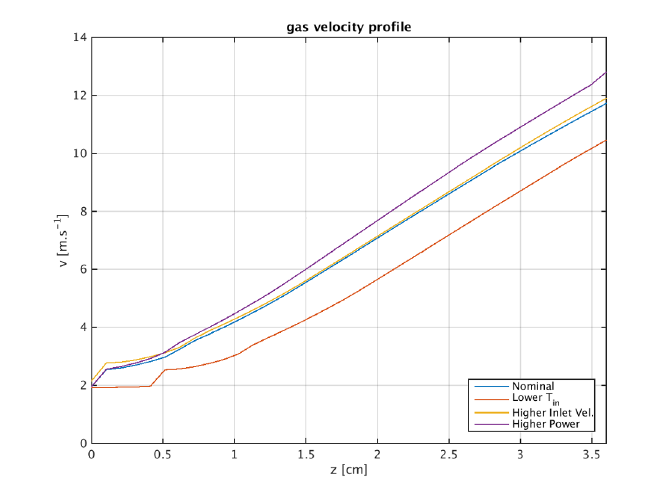
Figure 1: Void velocity profiles simulated by